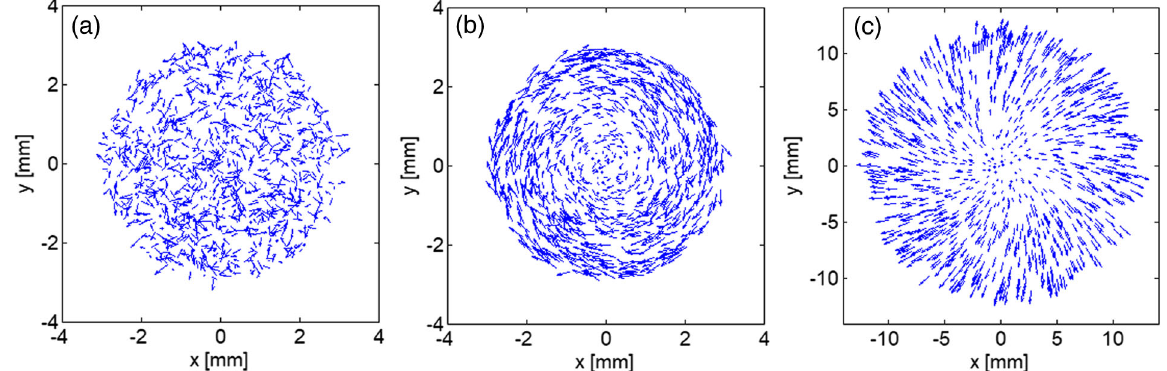
dump.FIG. 1. Vector plots with arrows depicting individual particles in a beam, defined by transverse momentum in x and y. (a) At the location of the cathode, inside the magnetic field, the random vectors are a result of the Maxwell Boltzmann thermal distribution of momenta. (b) Immediately downstream of the magnetic field at a beam waist, dominated by angular momentum. (c) Further downstream in free space where the beam is heavily